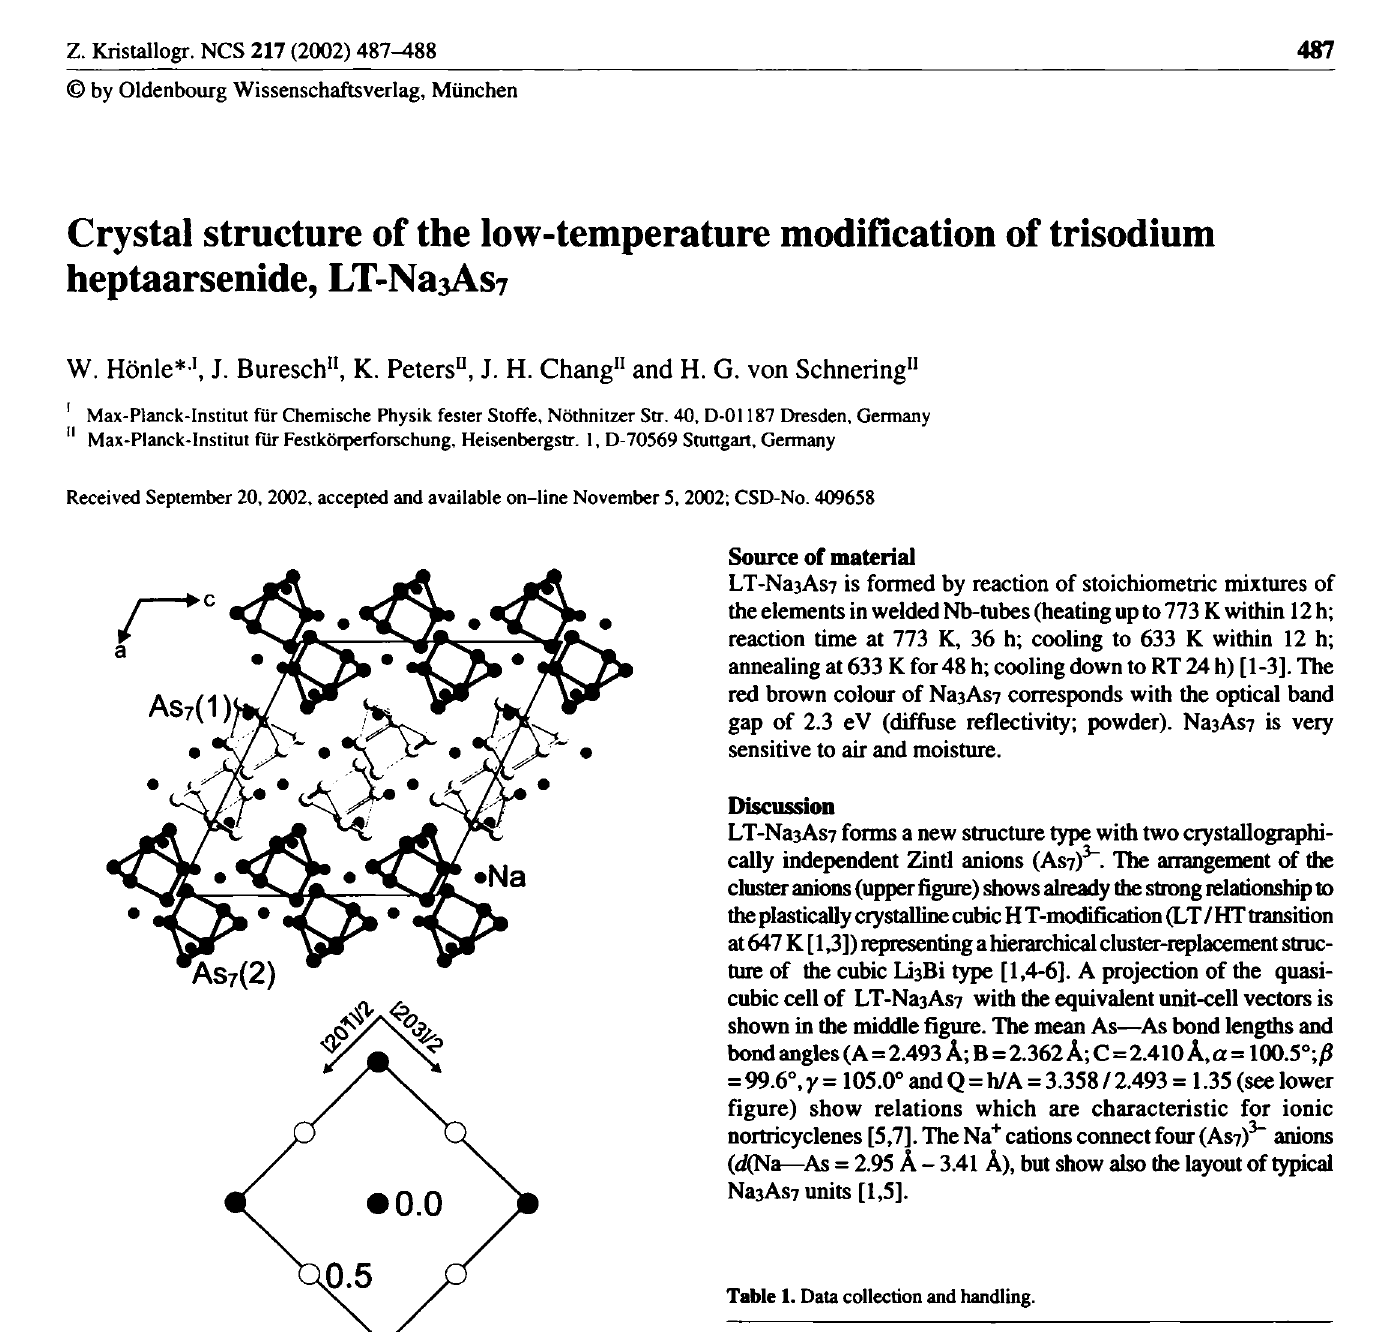
Table 1. Data collection and